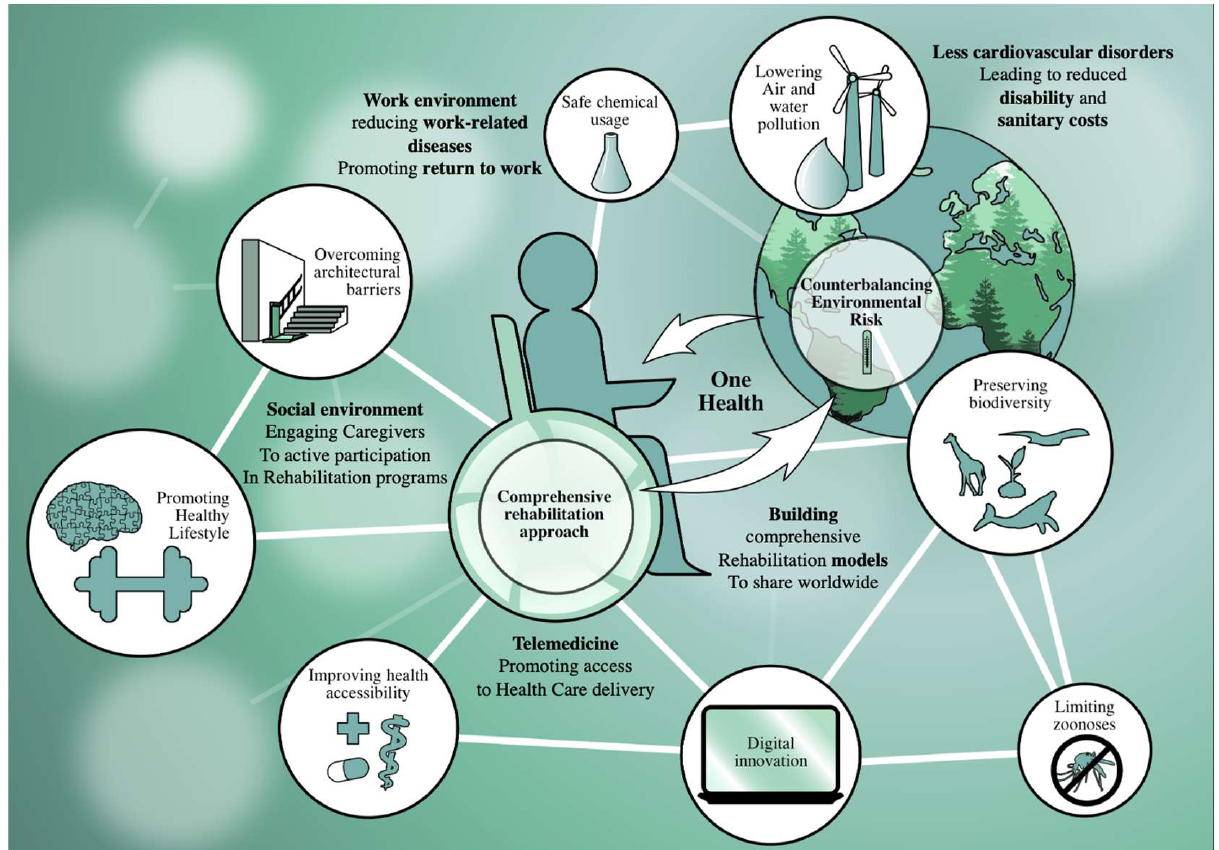
Figure 1. One health approach integrated into the modifiable environmental factors affecting disa- bility.